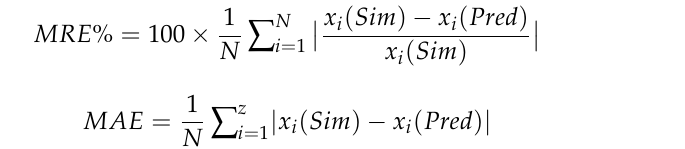
Figure 12. Architecture of the proposed network in order to determine the void fractions.